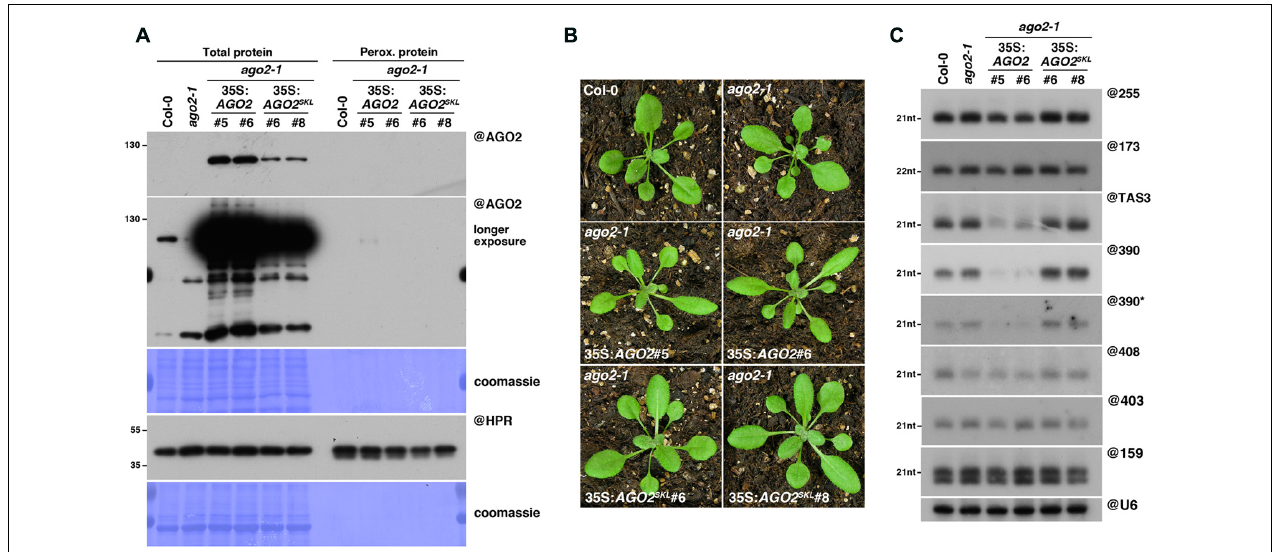
FIGURE 4 | AGO2 SKL is not imported into peroxisomes, while overexpression of AGO2 impacts the miR390/ TAS3 pathway. (A) Western analysis of plant peroxisomal marker hydroxypyruvate reductase (@HPR) and AGO2/AGO SKL (@AGO2) in total (left) and peroxisome (right) fractions obtained from Col0, 35S:AGO2/ ago2-1 (transgenic lines #5 and #6) and 35S:AGO2 SKL / ago2-1 (transgenic lines #6 and #8) plants. Total proteins also include ago2-1 . (B) Photos of the plants described in (A) . (C) Northern analysis of small RNAs (miR159, miR173, miR390, miR390 ∗ , miR403, miR408, TAS1 -derived siRNA (255), and TAS3 -derived siRNA 5 (cid:48) D7(+) (TAS3)) in total leaf tissue of plants described in (A,B) was obtained by sequential rounds of probing and stripping the same membrane. Northern analysis was performed on a low-resolution gel. Accumulation of snU6 was used as RNA loading control, while coomassie staining was used as protein loading control. Figure source data can be found with the Supplementary